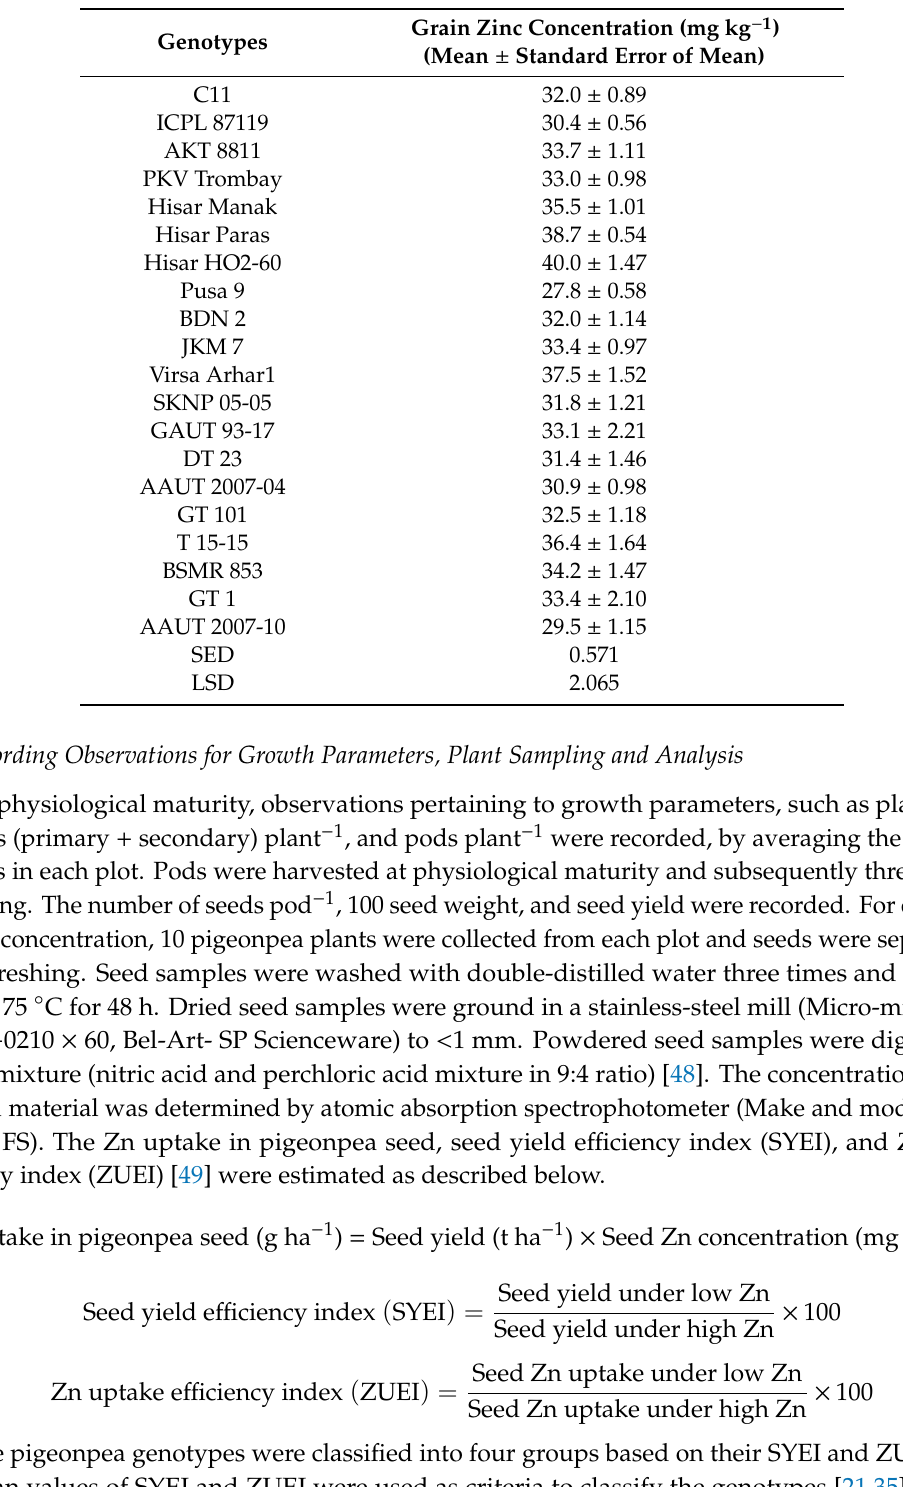
Table 7. Initial seed zinc concentration of pigeonpea genotypes used in the study. SED = standard error of di ff erence; LSD = least significant di ff